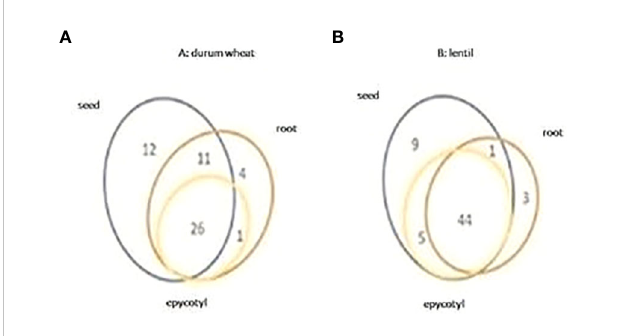
FIGURE 1 Venn diagram of the metabolites detected in all tissues analyzed in durum wheat (A) and in lentil (B) .